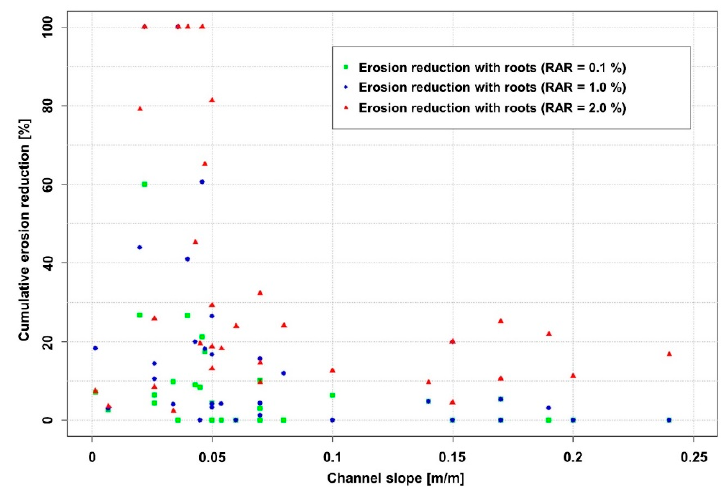
Figure 11. Stabilizing effects of roots on hydraulic bank erosion in relation to channel slope. The points represent the cumulative erosion reduction (%) with RAR = 0.1% (green), RAR = 1% (blue) and RAR = 2% (red).